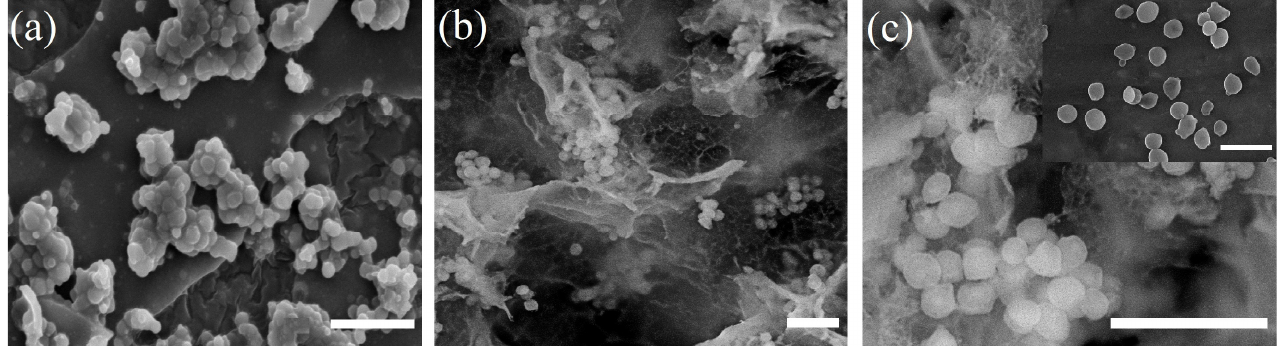
Figure 5. Fluorescence microscopy: ( a , b ) suspension of yeast Ogataea polymorpha VKM Y-2559; ( c , d ) slice of STP EG -composite matrix with immobilized yeast Ogataea polymorpha VKM Y-2559; ( a , c ) cytochemical coloring of the yeast cell wall by fluorescent dye Calcofluor White; and ( b , d ) cytochemical coloring of the yeast by fluorescent dye Live/Dead Yeast Viability Kit. The bar represents a 10 µm scale.